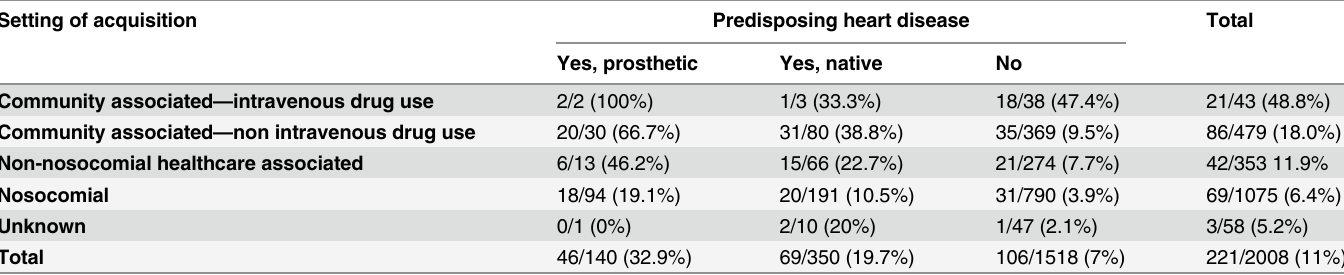
Table 5. Rate of IE according to predisposing heart disease and setting of